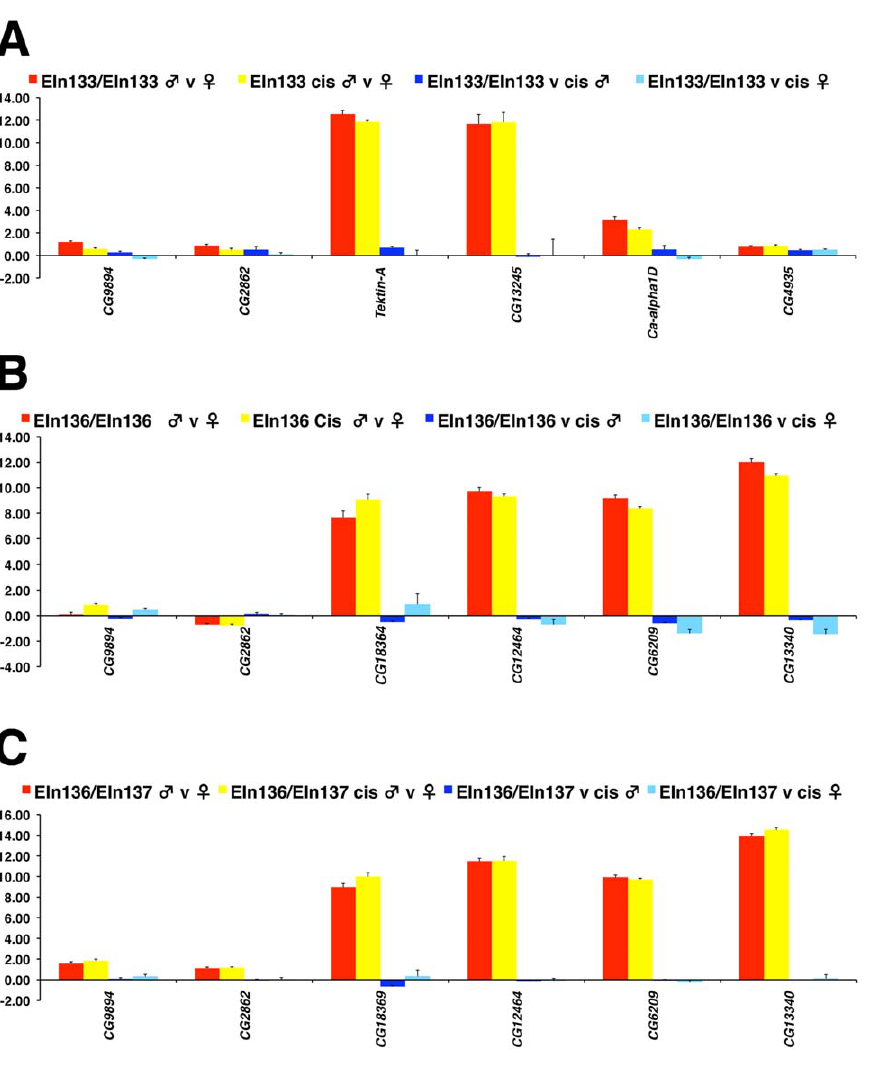
Figure 4. Confirmation by quantitative Real-Time PCR. (A) Supporting the microarray experiments, four genes in the 35F neighbourhood and two genes flanking the other end of the inversion breakpoint at 23A3 show expected male-specific expression and no change in expression when inversion bearing males are compared with undisrupted progenitors. (B and C) Similar confirmation of the microarray data is seen with homozygous (B) and transheterozygous (C) inversions in the 50B neighbourhood. Note the small change in expression detected in females in